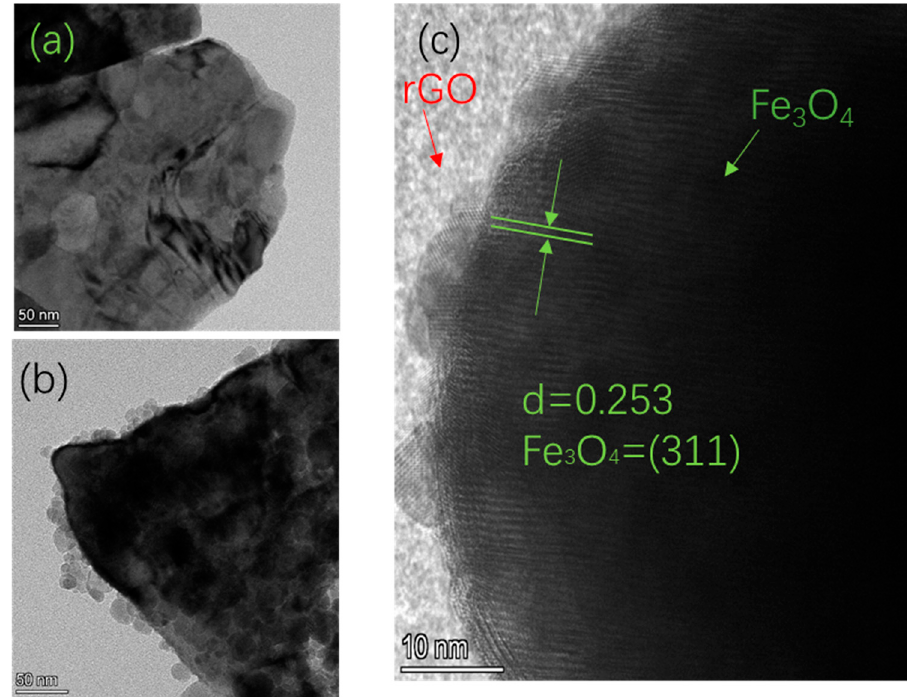
Figure 2. TEM images of ( a ) GO, ( b , c ) rGO/Fe 3 O 4 .